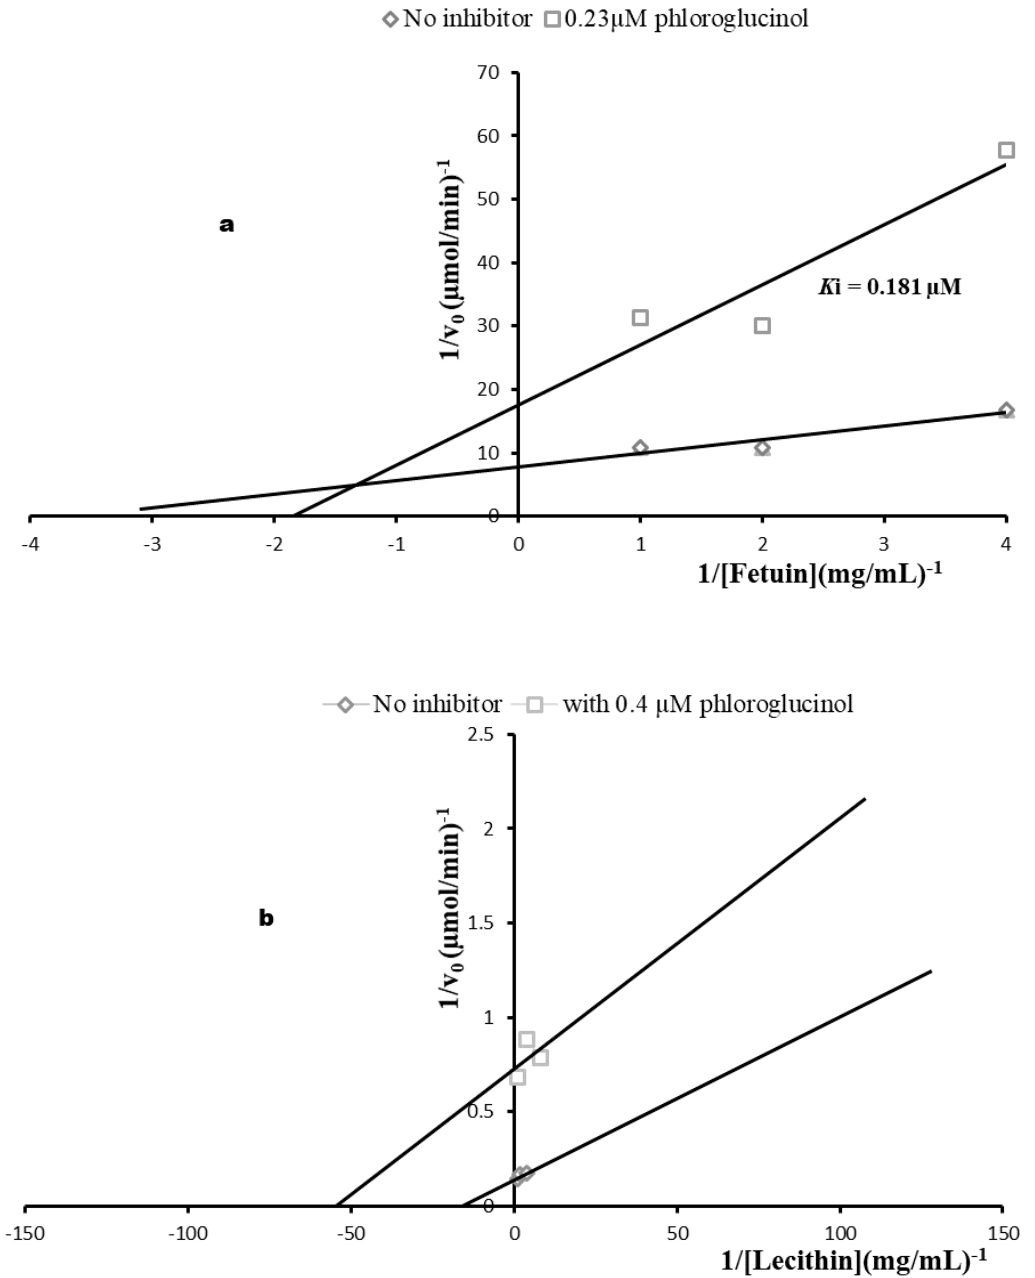
Figure 7. Double reciprocal plot of T. congolense sialidase ( a ) and PLA 2 ( b ) inhibitions using phloroglucinol. All data are presented as mean ± standard deviation of three independent experiments. Ki = Inhibition constant.